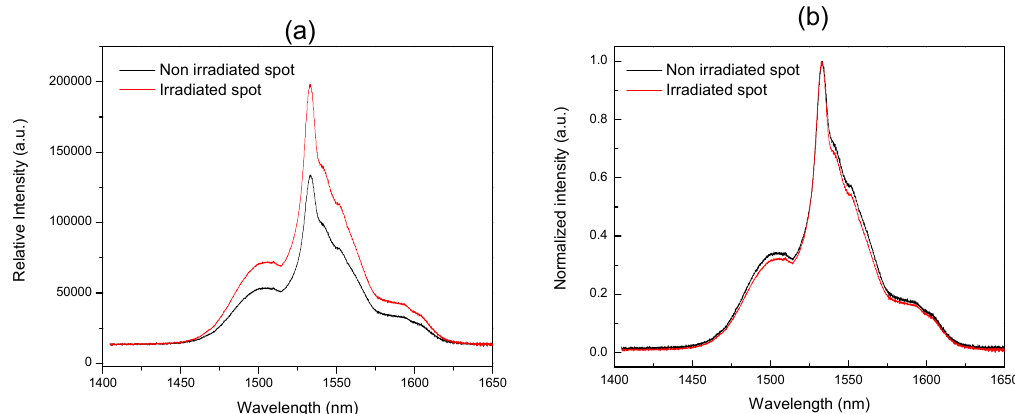
Figure 5. Emission ( a ) and normalized emission ( b ) spectra measured in non-irradiated and irradiated spots.